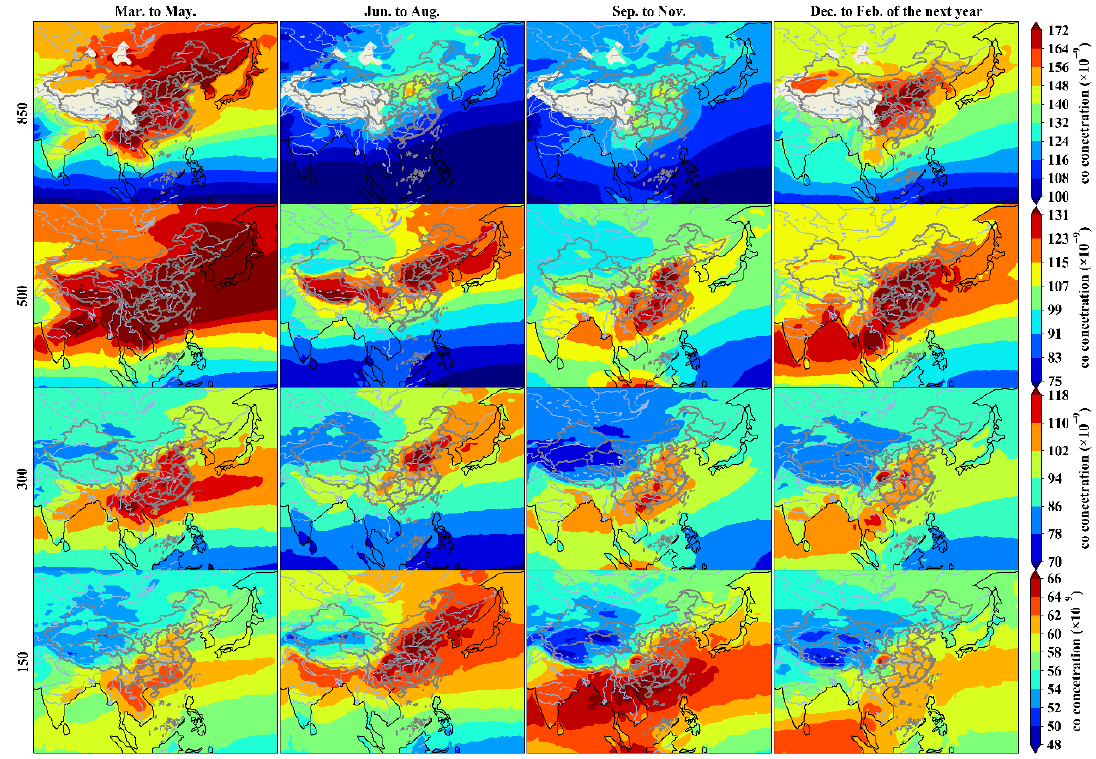
Figure 10. Four season spatial distribution map of different tropospheric pressure layers from 2002 to 2020.